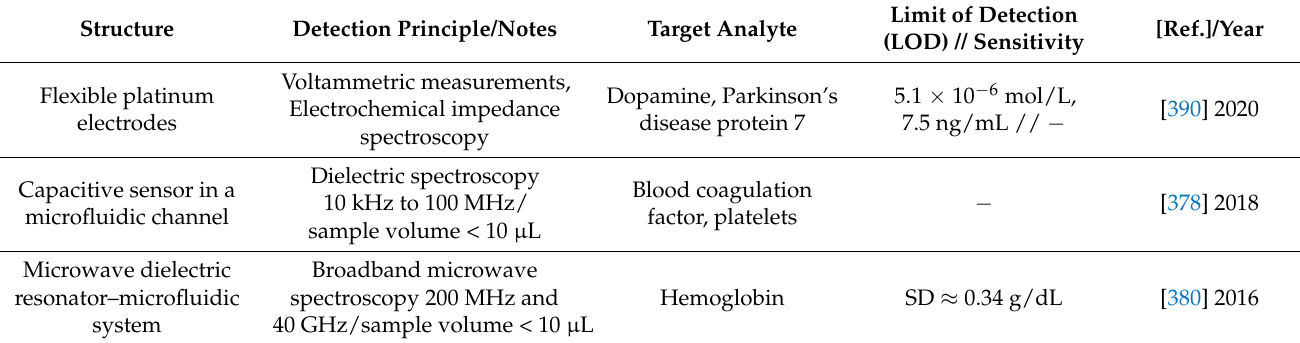
Table 8. Some examples of the applying of impedance methods for protein detection in recent